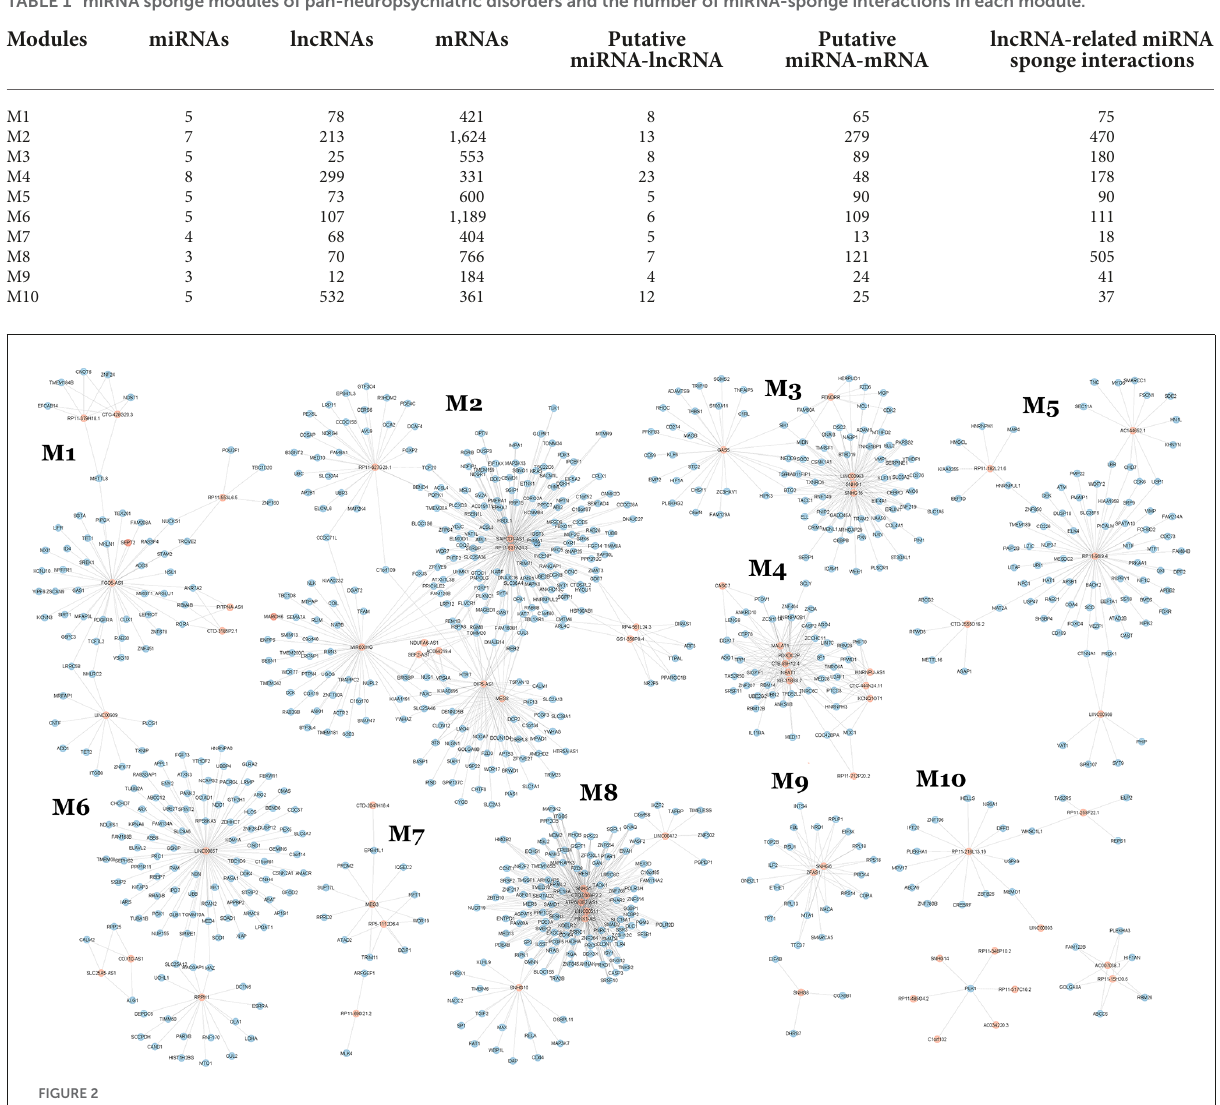
TABLE 1 miRNA sponge modules of pan-neuropsychiatric disorders and the number of miRNA-sponge interactions in each module. Modules